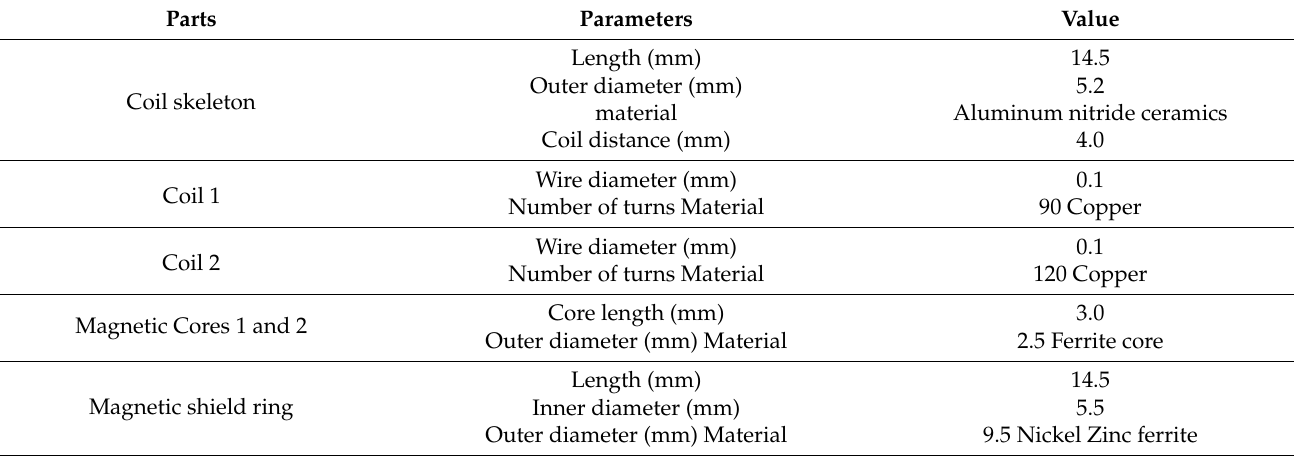
Figure 2. Structure optimization of DIFOD sensor. Table 1. Sensor structure design parameters.